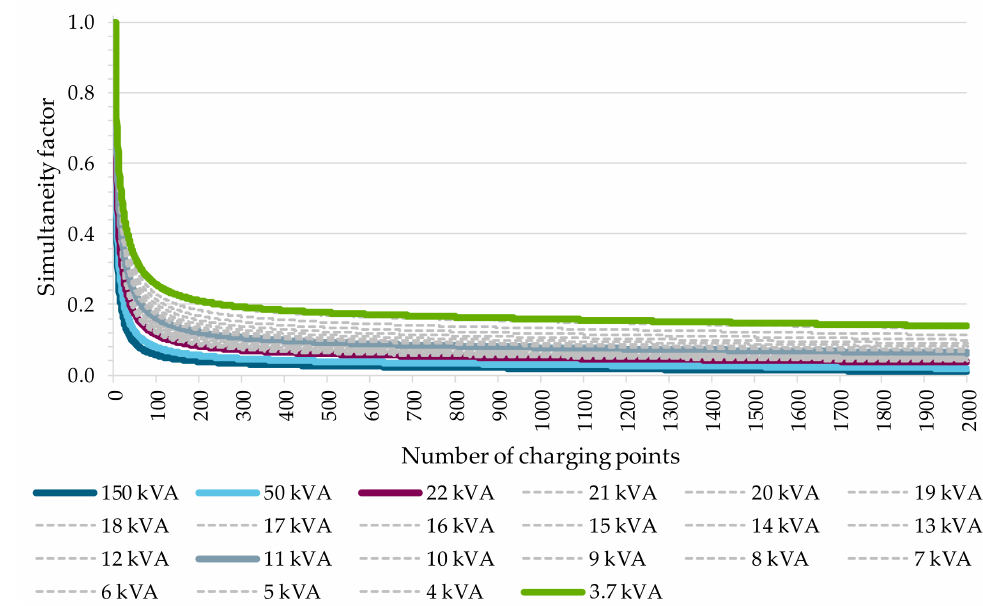
Figure 5. Example of cumulative charging capacities with a different calculation of simultaneities for charging points (CPs).